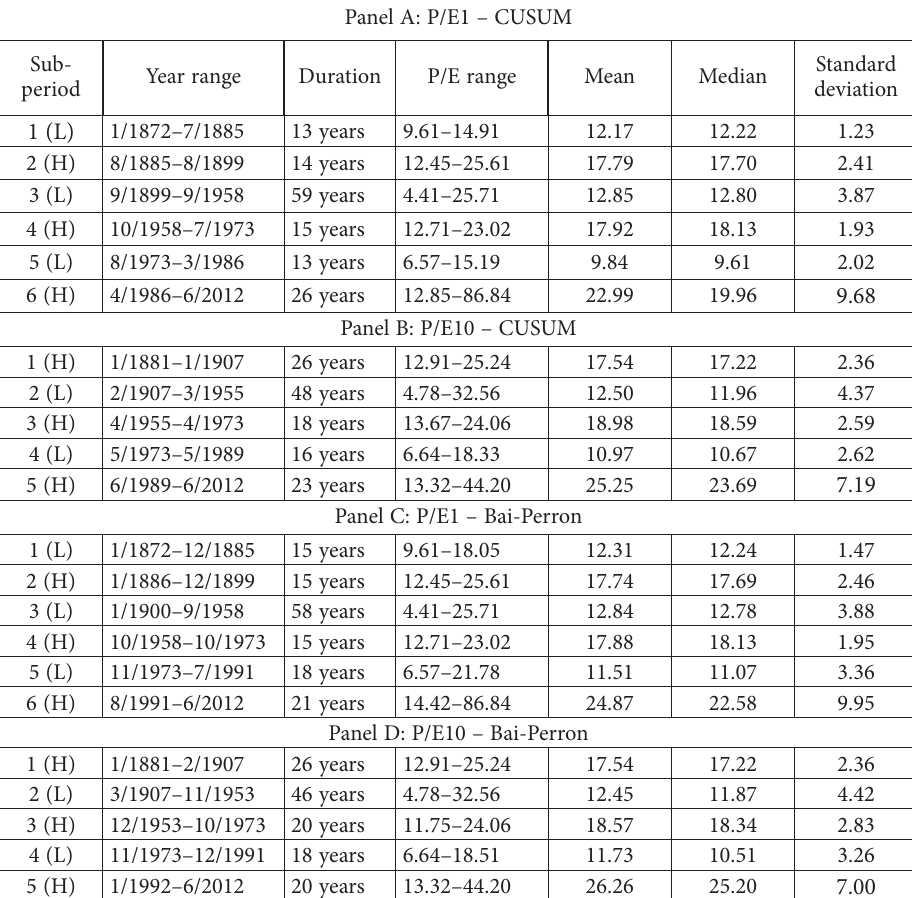
Table 3. Summary statistics for structurally different